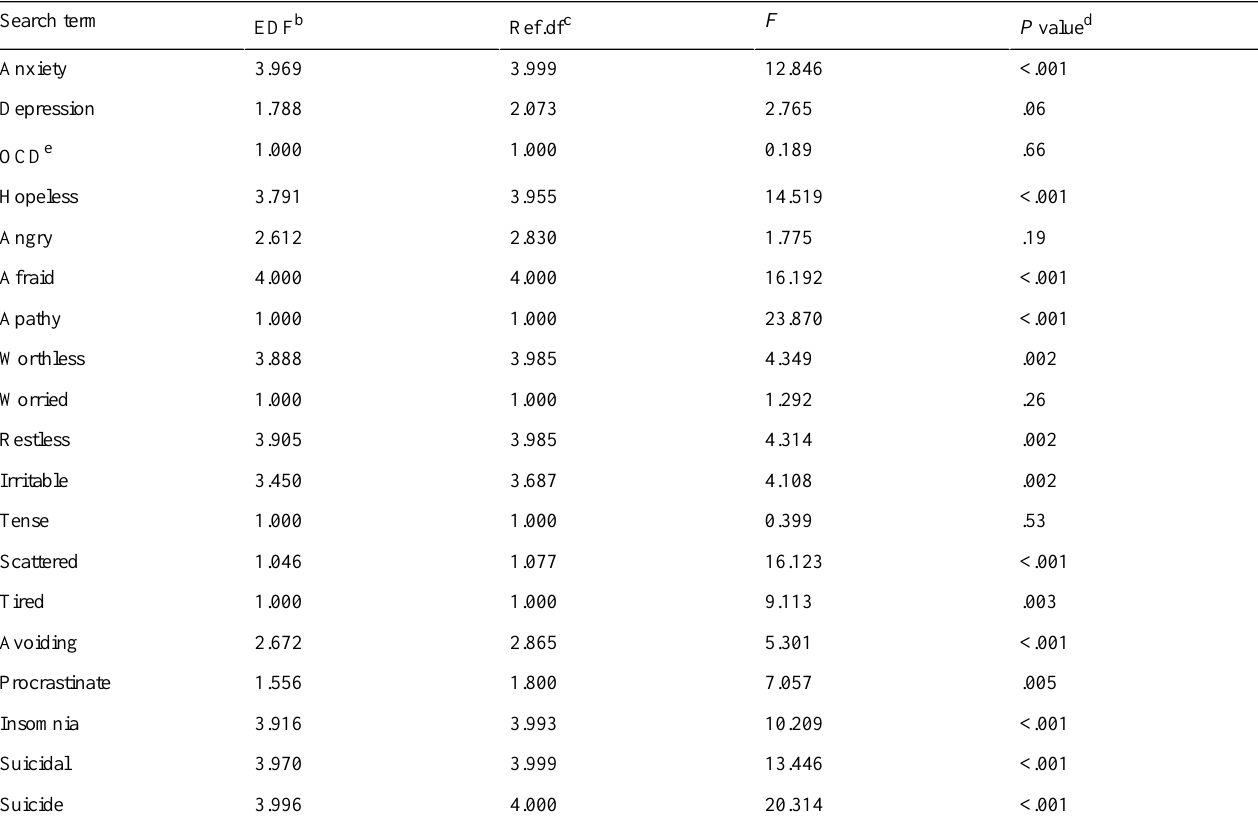
Table 2. Changes in search behavior related to stay-at-home orders.